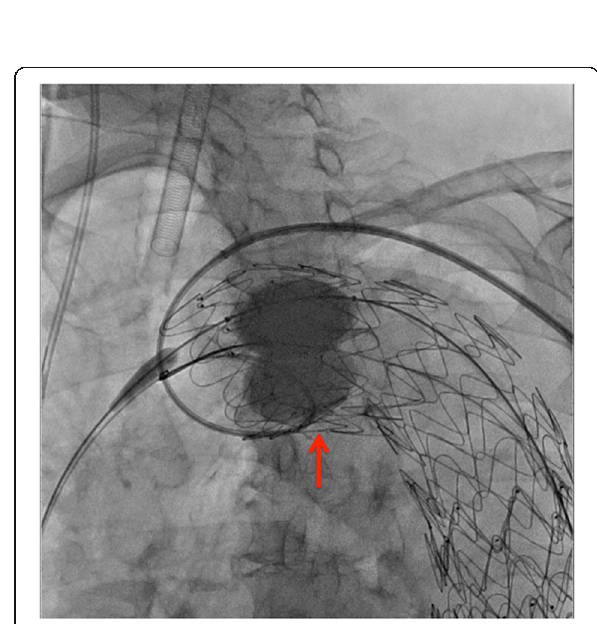
Fig. 4 Fluoroscopic image under reinforcement of proximal sealing using ballooning. Pressure applied on the proximal side of the SG using Tri-Lobe Balloon Catheter (red arrow), which reinforces the proximal